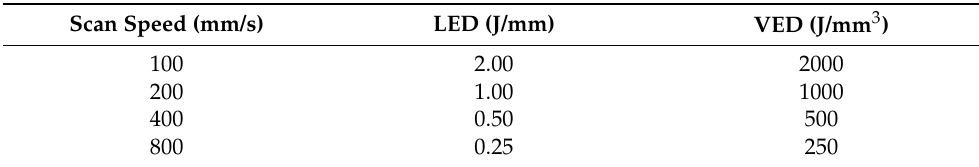
Table 1. Scan speeds with associated line and volumetric energy densities used to print pure molybdenum and